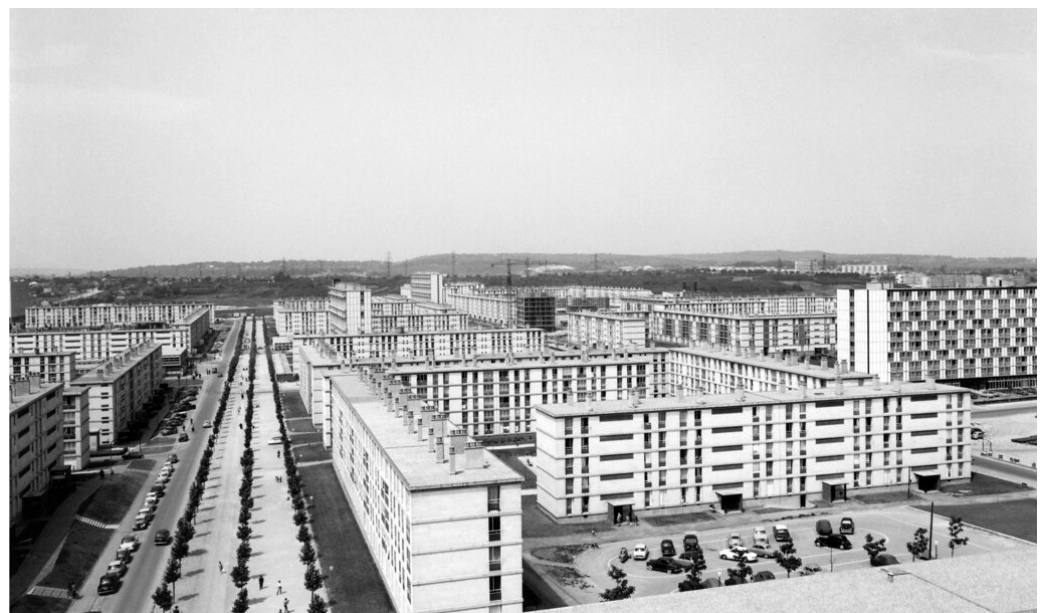
Figure 2. Sarcelles, an emblematic case. Source: INA